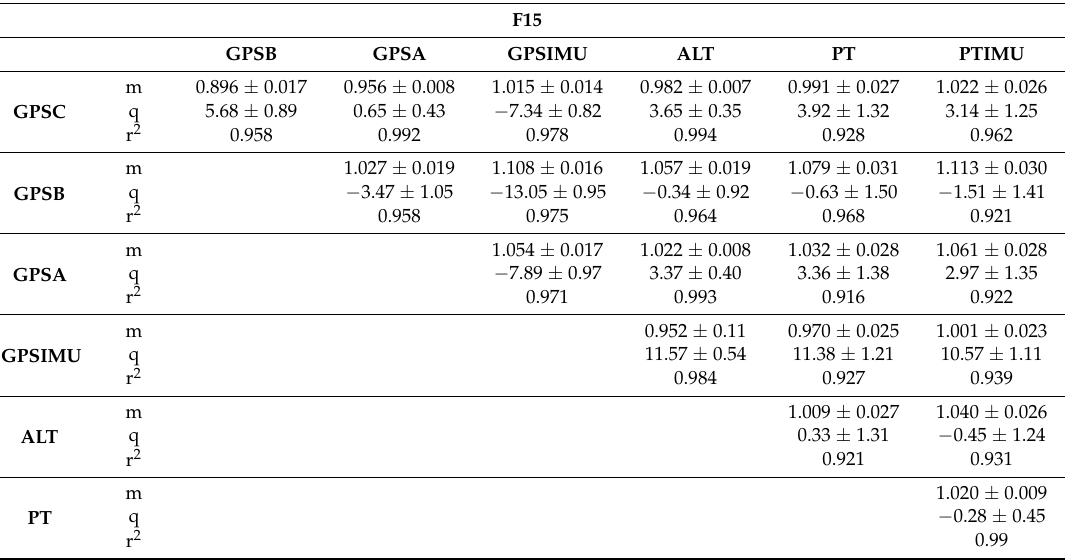
Table A3. Linear regression data of F15 (DATASET 2 α ).